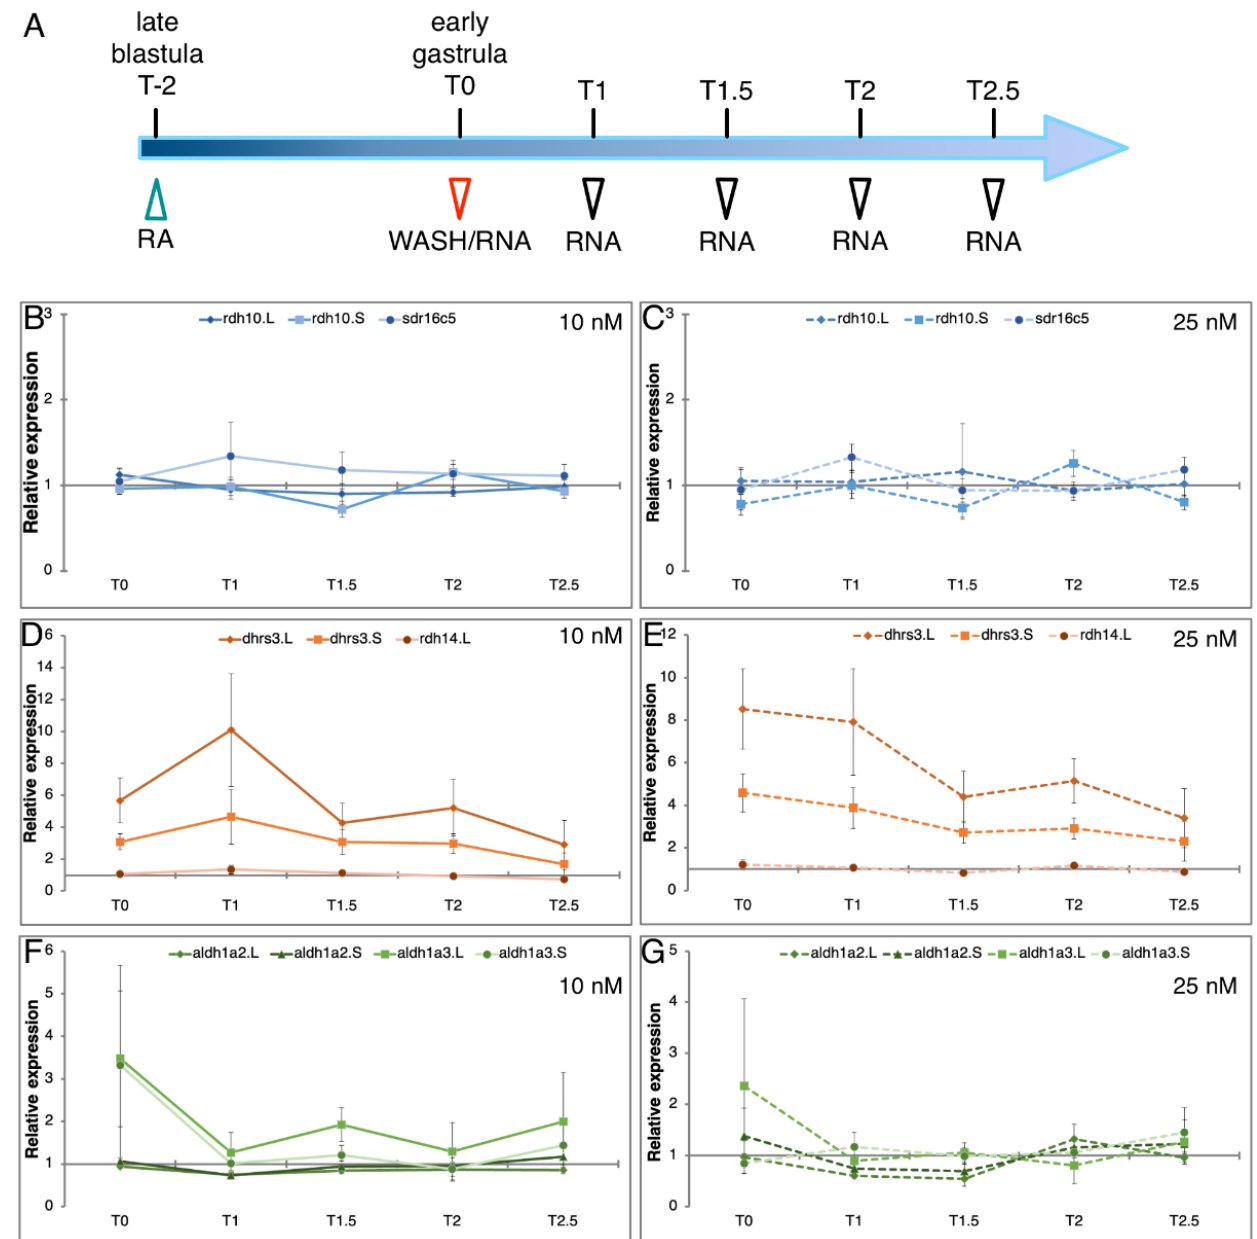
Figure 6. Recovery of RA metabolic gene expression following transient RA manipulation. ( A ) Em- bryos were subjected to a two-hour (T-2–T0) RA treatment (10 or 25 nM) from late blastula (st. 9) to early gastrula (st. 10.25). At T0 the treatment was terminated (washed; green arrowhead) and the embryos were further incubated. Samples were collected at different times (red and black arrowheads) for expression analysis. ( B , C ) Kinetic analysis of rdh10 .L, rdh10 .S, and sdr16c5 expression changes. ( D , E ) qPCR analysis of the expression of dhrs3 .L, dhrs3 .S, and rdh14 . ( F , G ) Analysis of the aldh1a2 .L, aldh1a2 .S, aldh1a3 .L, and aldh1a3 .S expression. Table 4. Regulation tightness score for the RA network homoeologs and singletons.